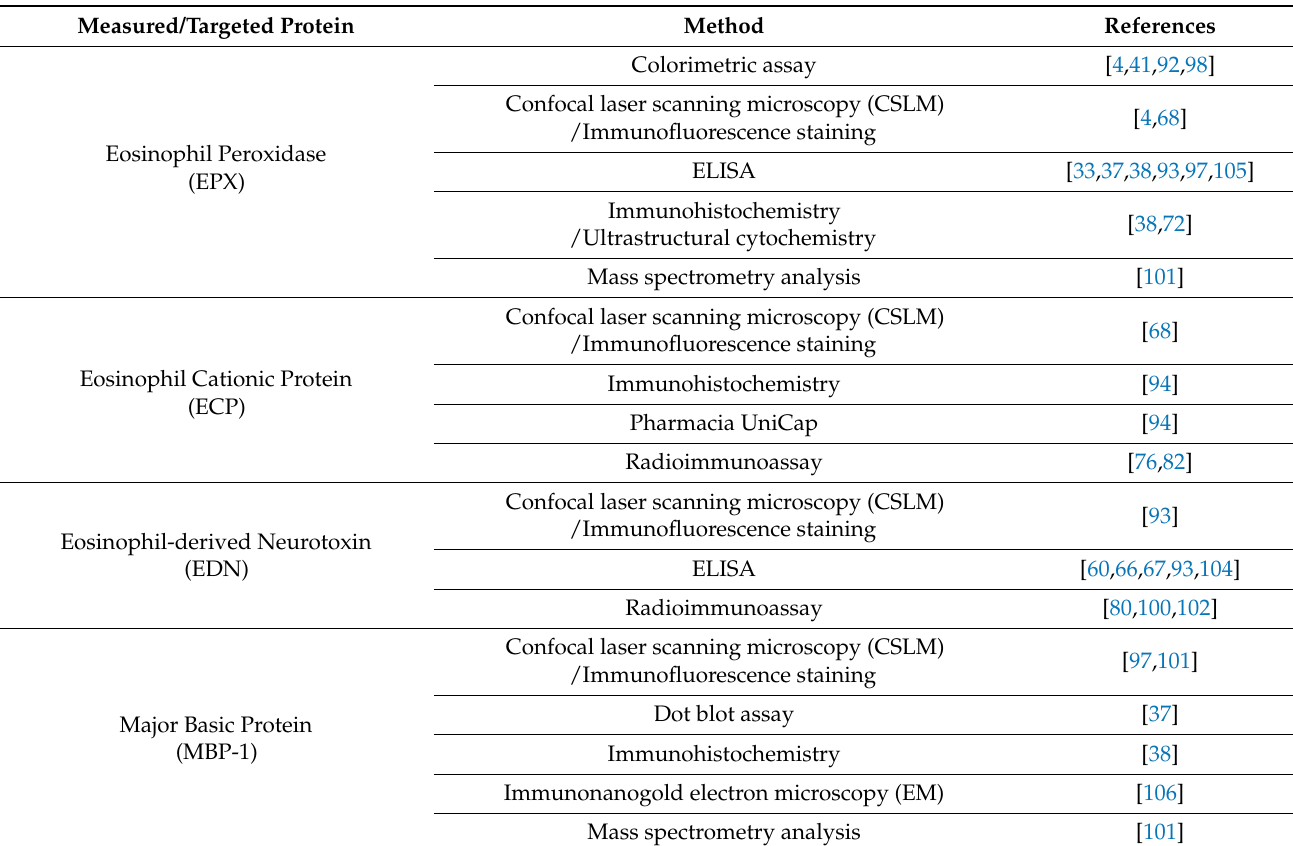
Table 2. Methods and targeted proteins employed to assess eosinophil